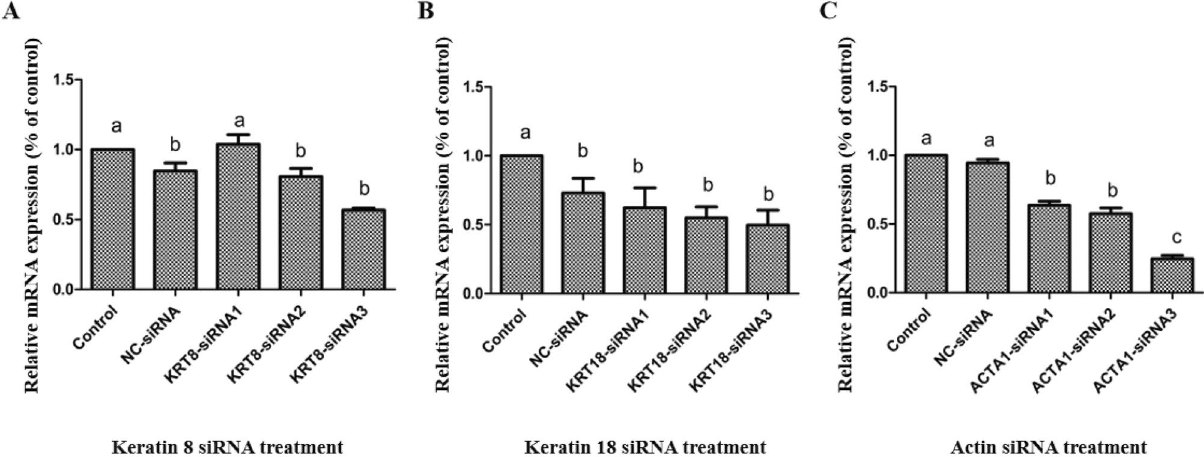
Figure 5. ( A - C ). Gene-silencing efficiency of siRNA-KRT8, KRT18, and ACTA in IPEC-J2. After transfection with different pairs: negative control (NC)-siRNA, siRNA1, siRNA2, siRNA3) of KRT8, KRT18 and ACTA sequences for 24 h, mRNA expression levels of these three cytoskeleton proteins in different siRNA treatments were assessed using qRT-PCR. ( A ). Keratin 8 siRNA treatment; ( B ). Keratin 18 siRNA treatment; and ( C ). Actin siRNA treatment. Data are represented as mean ± SEM. Different lowercase letters are significantly different ( p <